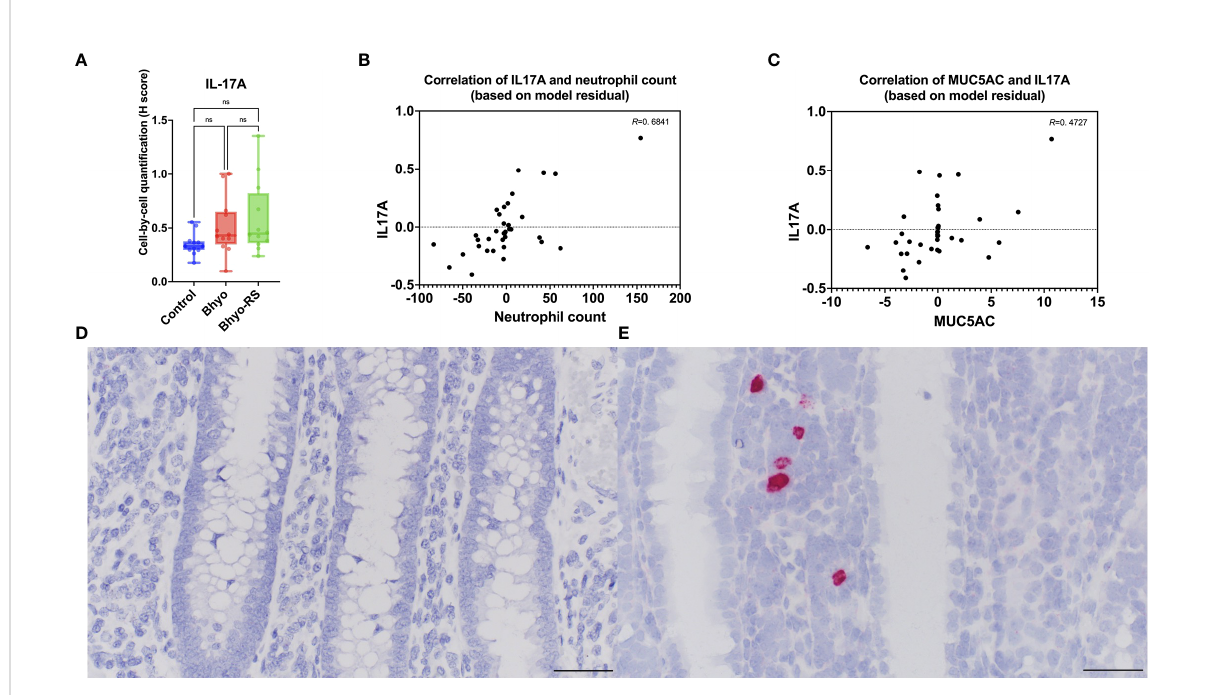
FIGURE 6 IL-17A expression was signi fi cantly different between the three groups ( P < 0.05). The post hoc Dunn ’ s test showed ( A , P =0.057) showed that the Bhyo-RS group (E) had a tendency of higher IL-17A expression compared to the controls (D) . A moderate correlation was found between